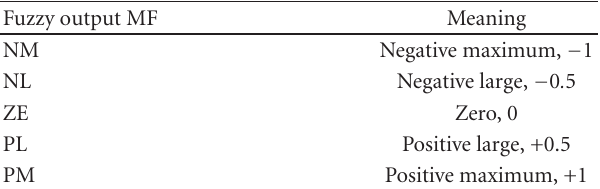
Figure 8: On/o ff test of Burkert solenoid valve for pressure range 20–100